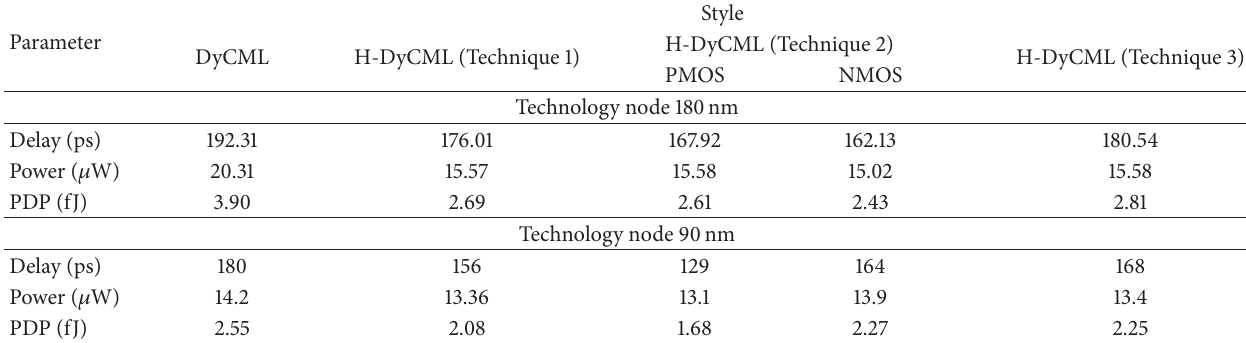
Table 1: Performance comparison of the existing DyCML and the proposed H-DyCML AND gate.